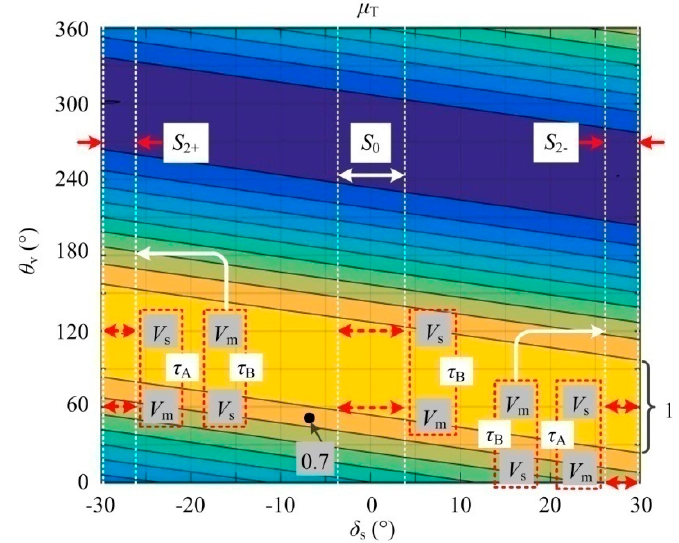
Figure 10. Two-dimensional contour map of torque error active factors.